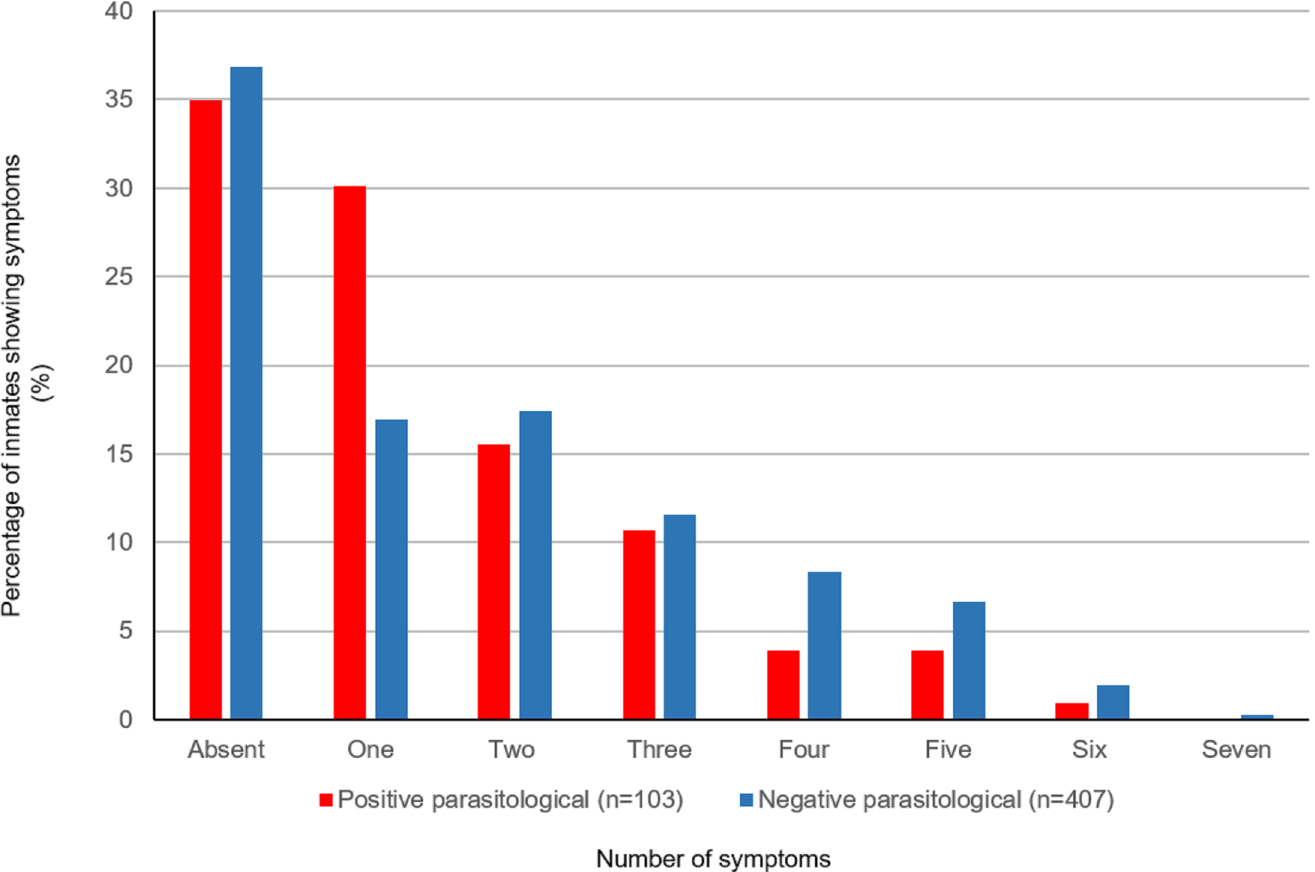
Fig 1. Number of symptoms experienced by group according to the results of parasitological examination. Symptoms presentedby the studied population,distributedaccordingto their number and percentage of patients with positive parasitologicalexamination (red) or negative parasitological examination